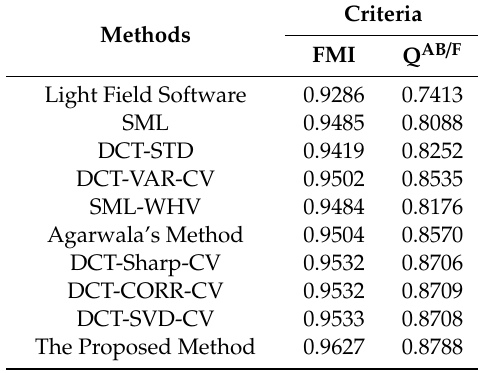
Figure 13. Comparison of ‘Cup’ image results: ( a ) Light Field Software, ( b ) SML, (c) DCT-STD, ( d ) DCT-VAR-CV, ( e ) SML-WHV, ( f ) Agarwala’s method, ( g ) DCT-Sharp-CV, ( h ) DCT-CORR-CV, ( i ) DCT-SVD-CV, ( j ) The Proposed Method. Table 2. Objective evaluation of the image results (non-reference fusion metrics) for ‘Cup’ image.